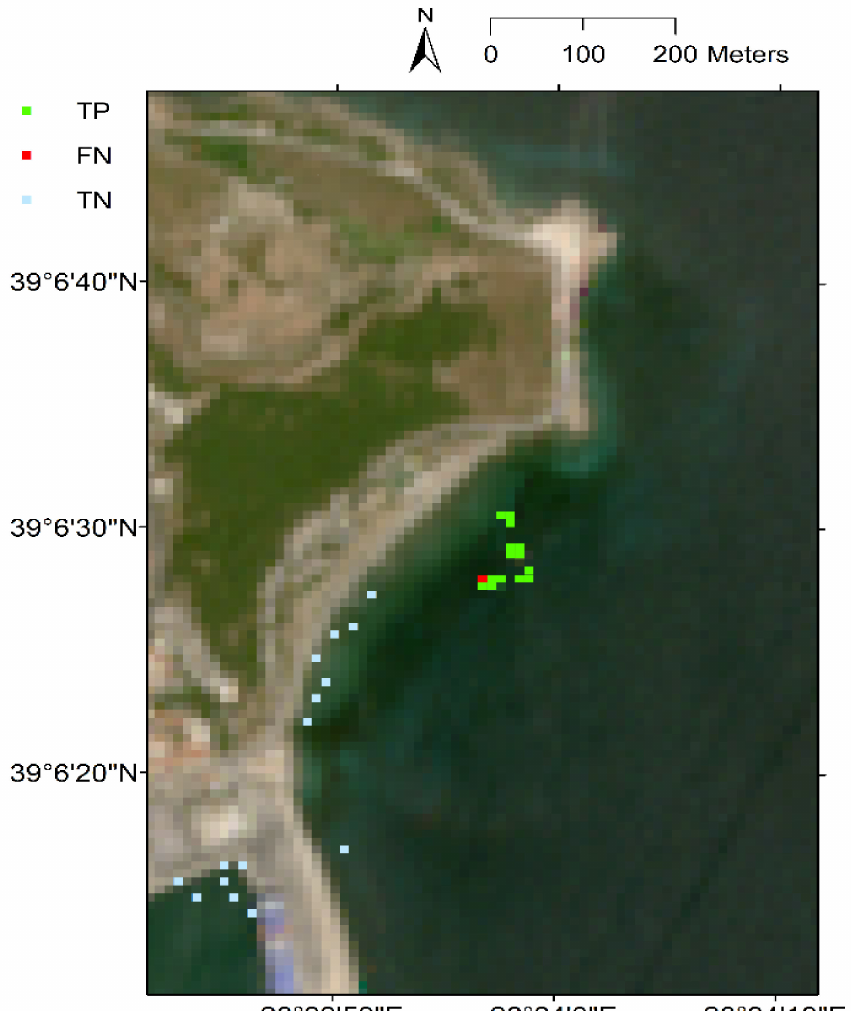
Figure 6. Predicted grids with/without presence of floating plastics for the 30-grid validation data obtained using the support vector regression